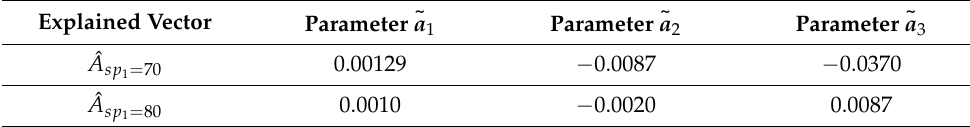
parameters’ values (procedure 1